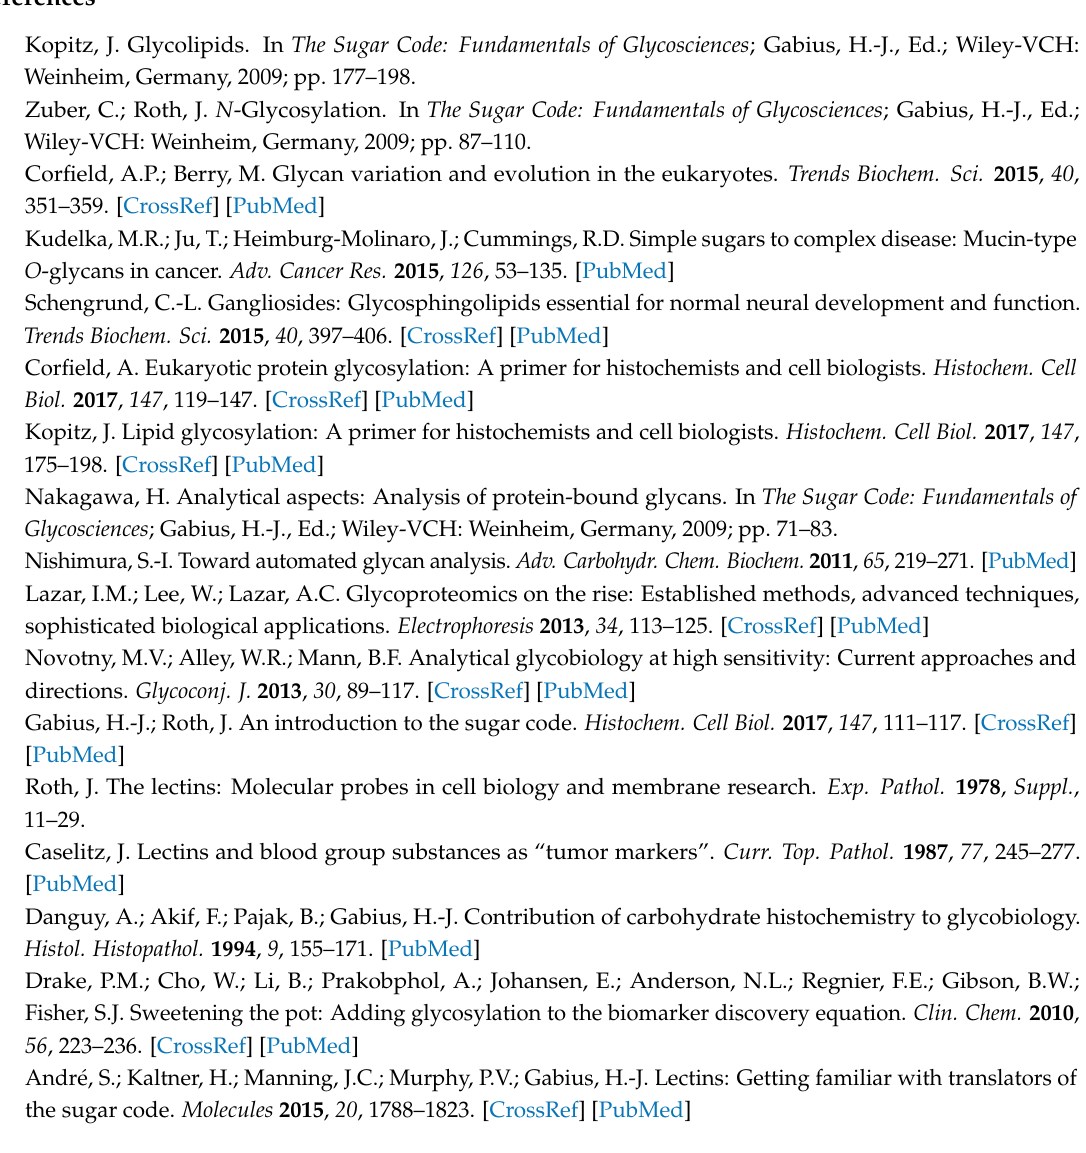
Supplementary Materials: The following are available online. Figure S1: Mass spectrometric fingerprinting of peptides obtained by treatment of Gal-8S (NC) with trypsin; Table S1a: Calculated and experimental masses of c-ions observed in the reISD spectra for Gal-8 (NN); Table S1b: Calculated and experimental masses of z + 2-ions observed in the reISD spectra for Gal-8